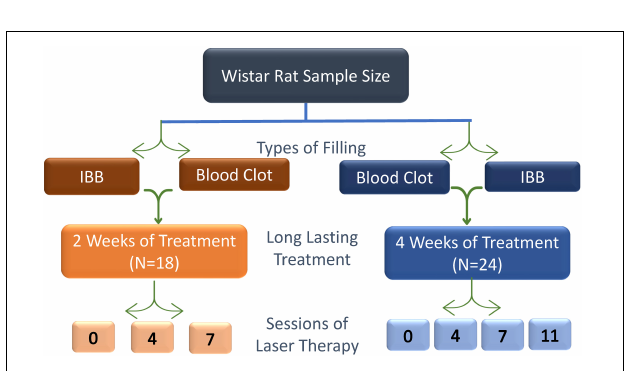
FIGURE 2 | Schematic design used to achieve the aim of this study, the effectiveness, and the number of sessions of low-level LT required to improve the recovery of bone injury. Sessions were scheduled to occur at intervals of 48